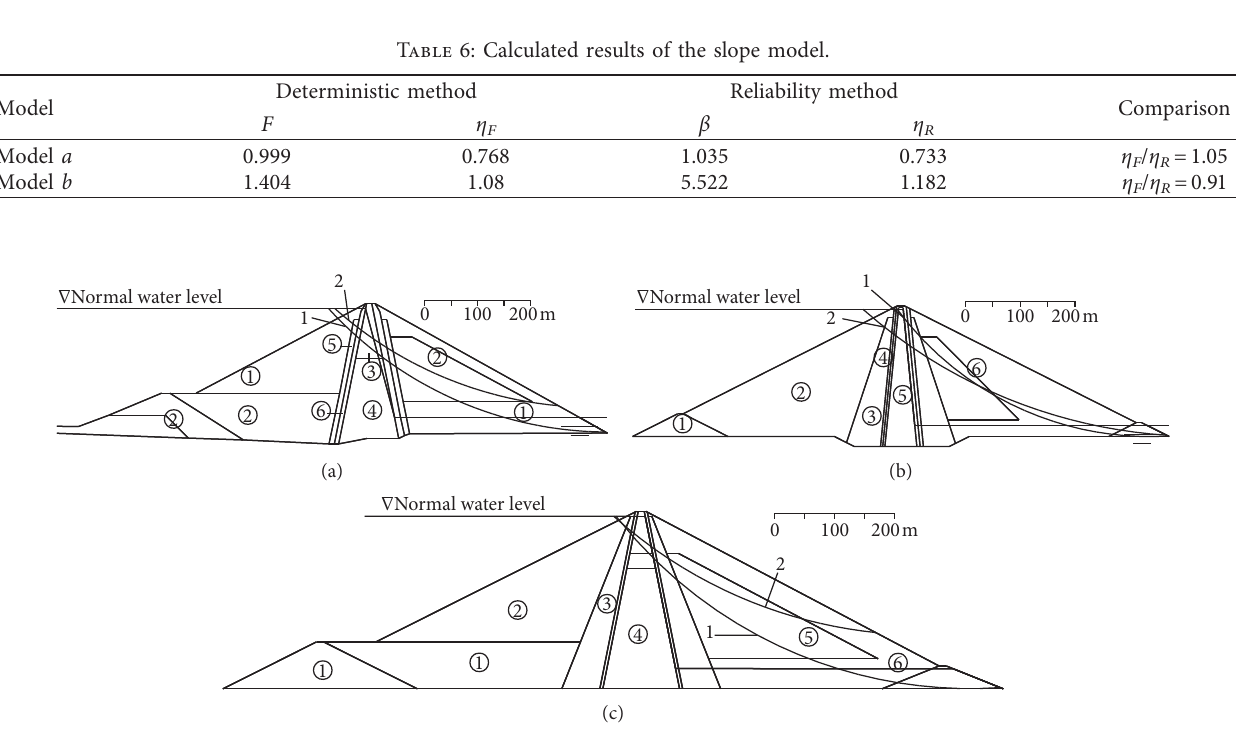
Figure 3: The profile diagram for the stabilities of the selected three ultrahigh dams in China with heights of more than 200m: (1) critical slip surface under normal conditions; (2) critical slip surface under seismic conditions. (a) Nuozhadu. (b) Shangzhai. (c)